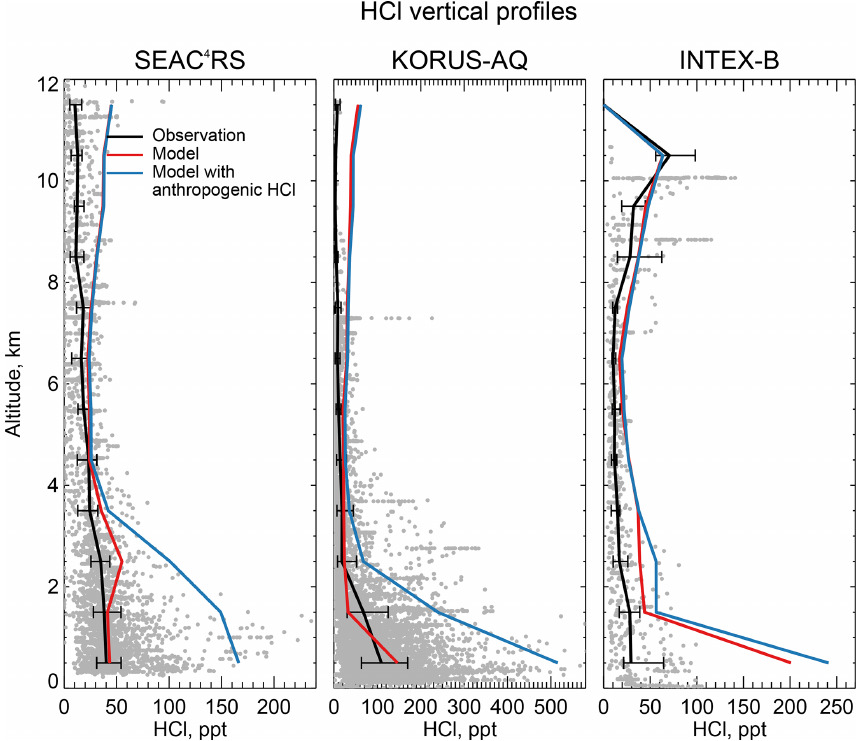
Figure 8. Vertical profiles of HCl mixing ratios during the SEAC 4 RS aircraft campaign over the Southeast US (95–81.5 ◦ W, 30.5–39 ◦ N) in August–September 2013, during the KORUS-AQ aircraft campaign over and around the Korean peninsula (120–132 ◦ E, 32–38 ◦ N) in May–June 2015 and during the INTEX-B aircraft campaign over the North Pacific (175 ◦ E–50 ◦ W, 40–61 ◦ N) in May 2006. Observations from the Georgia Tech CIMS instrument are shown as gray points (1min averages), with medians and 25th–75th percentiles in 1km vertical bins. Model values are sampled along the flight tracks and for the measurement period. Measurements below the detection limit are treated as the median of 0 and detection limit. Note the difference in scales among